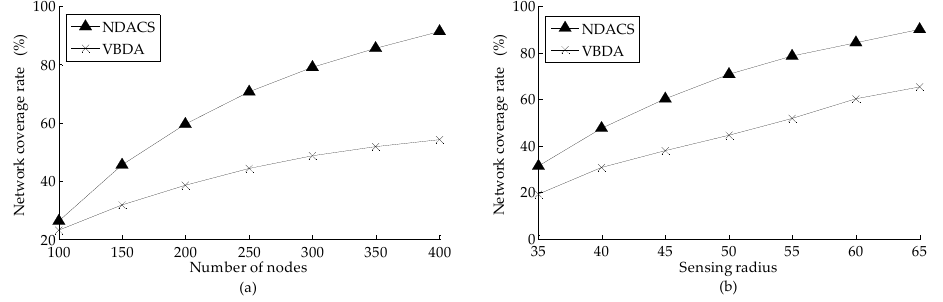
Figure 9. Comparison of network coverage rate between NDACS and VBDA: ( a ) comparison of network coverage rate between NDACS and VBDA varying with the number of nodes, and node sensing radius is 50 m; ( b ) comparison of network coverage rate between NDACS and VBDA varying with sensing radius, and the default number of nodes is 200.